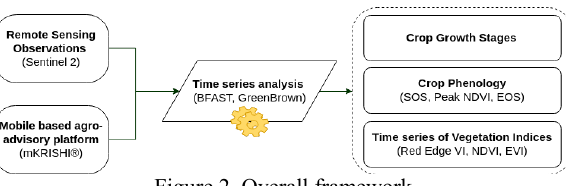
Figure 2. Overall framework